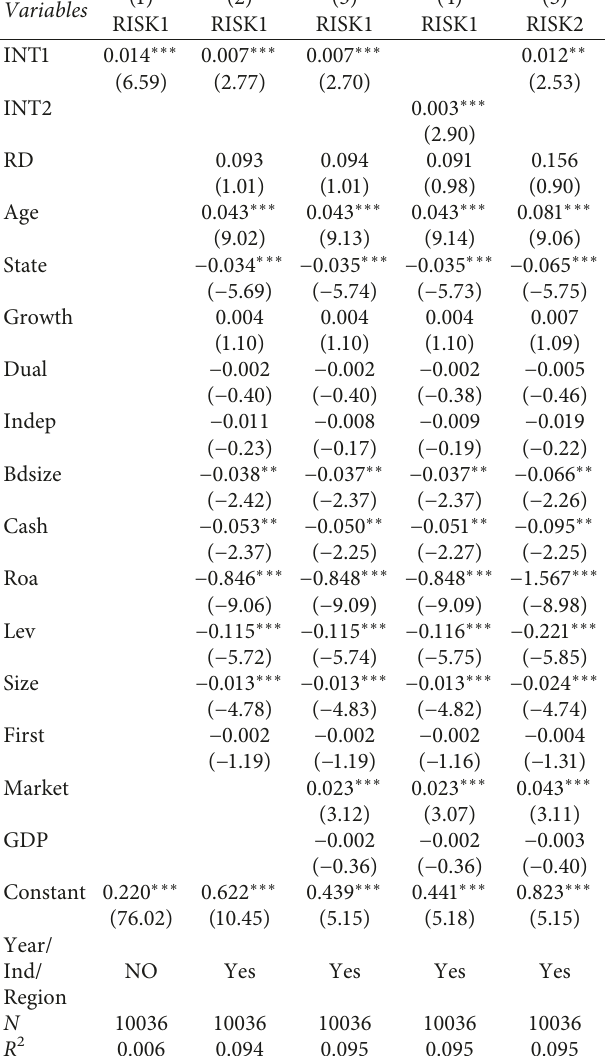
Table 3: The Internet-based business model and corporate risk- taking.